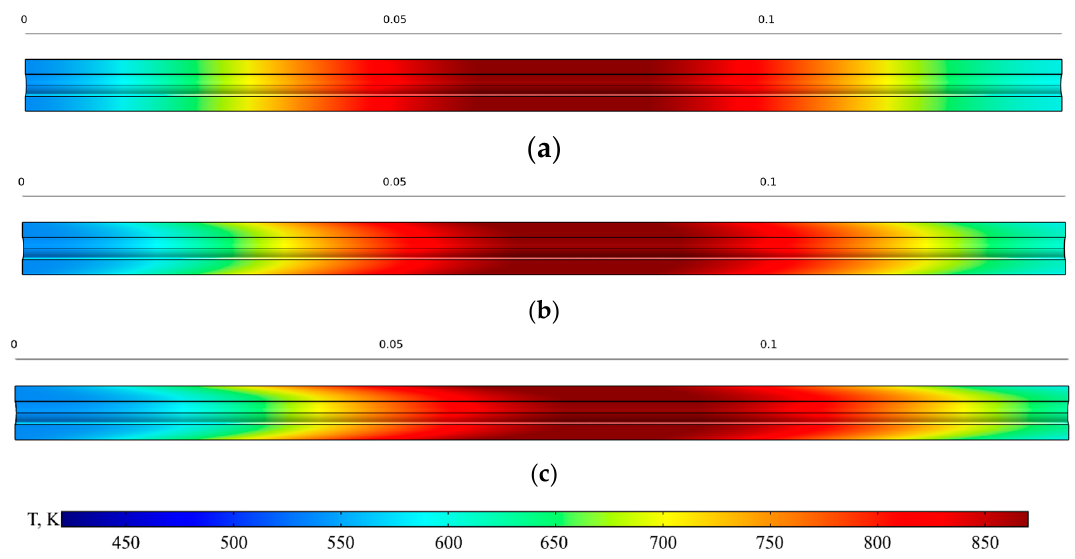
Figure 7. Temperature profile along the length of the reactor at a temperature of 600 °C and carrier gas flow rates of 0.05 ( a ), 1.5 ( b ), and 3.0 ( c ) L/min.